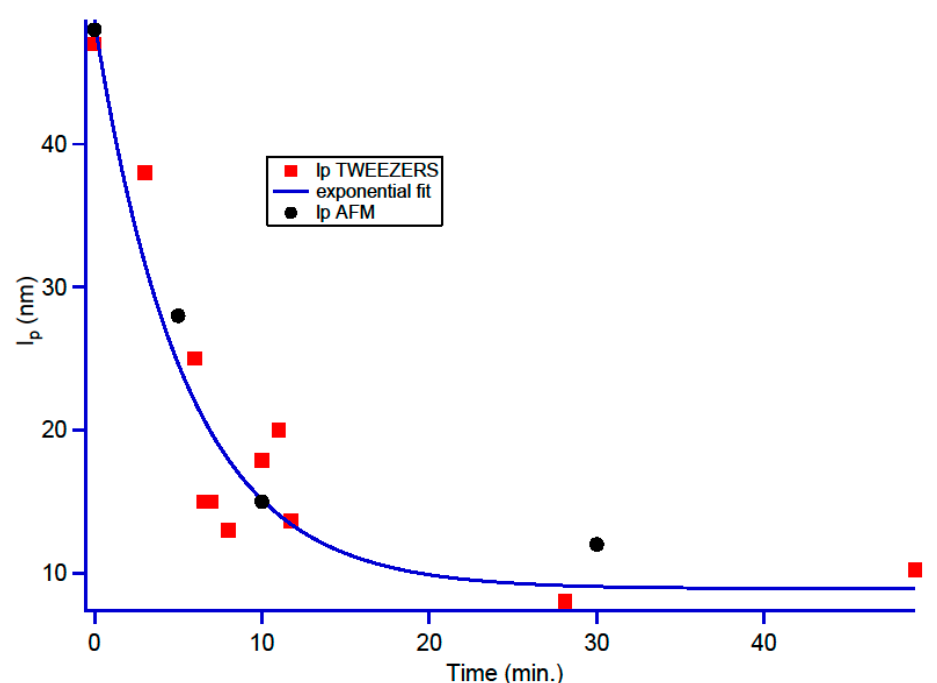
Figure 8. Persistence length decrease as a function of time for the optical tweezers (red dots) and AFM (black dots). An exponential adjustment was added on top of the experimental points to help visualization.